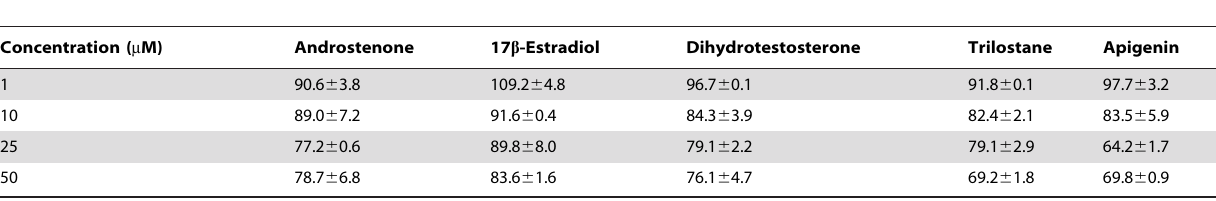
Concentration ( m